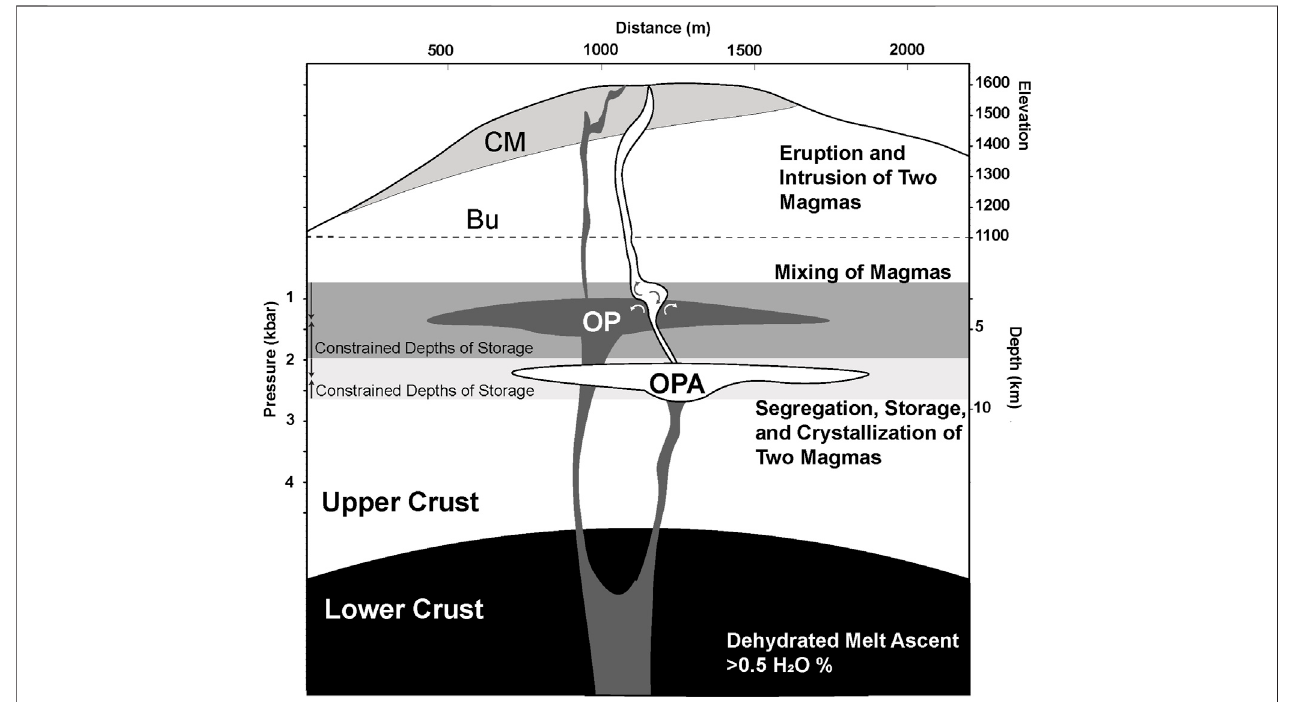
FIGURE9| SchematicdepictionofcrustalstorageconditionsfortheCMvolcano.Thevolcanicpro fi leabovethedashedlineisshownwithnoverticalexaggeration (VE). Regions below the dashed line are not shown to scale. Results of chemical and thermodynamic models indicate dry melts ( > 0.5 H 2 O%) ascended into the upper crust, where two batches segregated and crystalized different pressure conditions (i.e., depth). The OPA batch (white) crystalized at ~2 kbar while the OP batch (dark grey) was at < 1.5 kbar. Mixing of the two magmas is depicted as the lower OPA erupted concurrently with OP during the monogenetic eruption of CM.